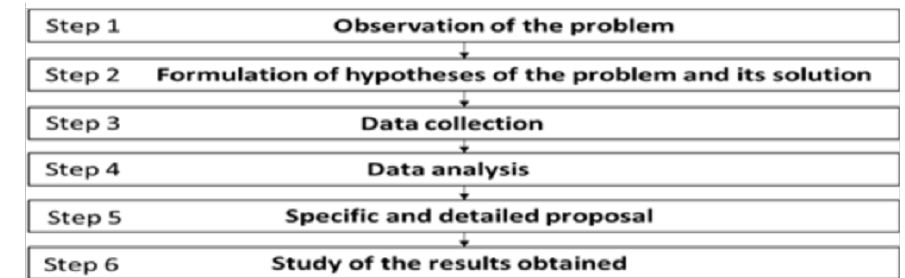
Figure 2: Steps to follow through Cal y